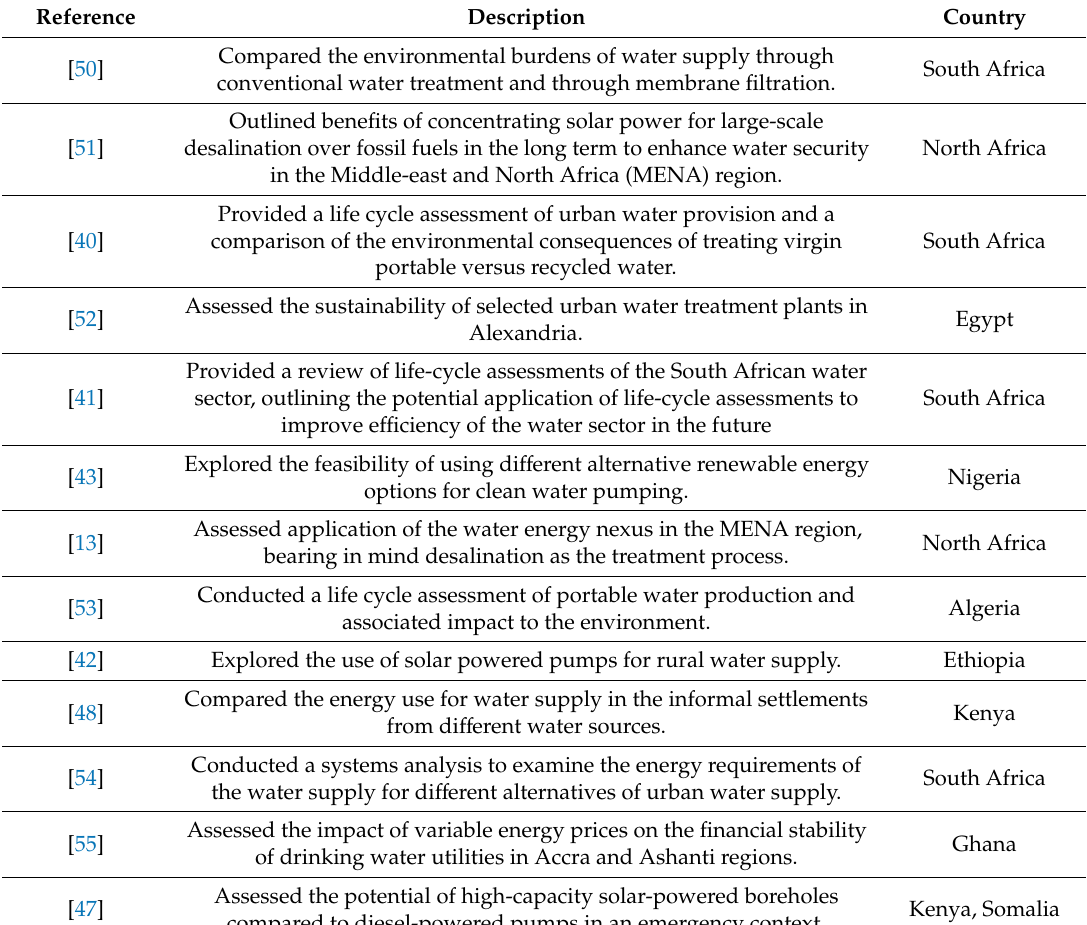
Table 1. Summary of available literature on energy assessment for water supply in Africa.